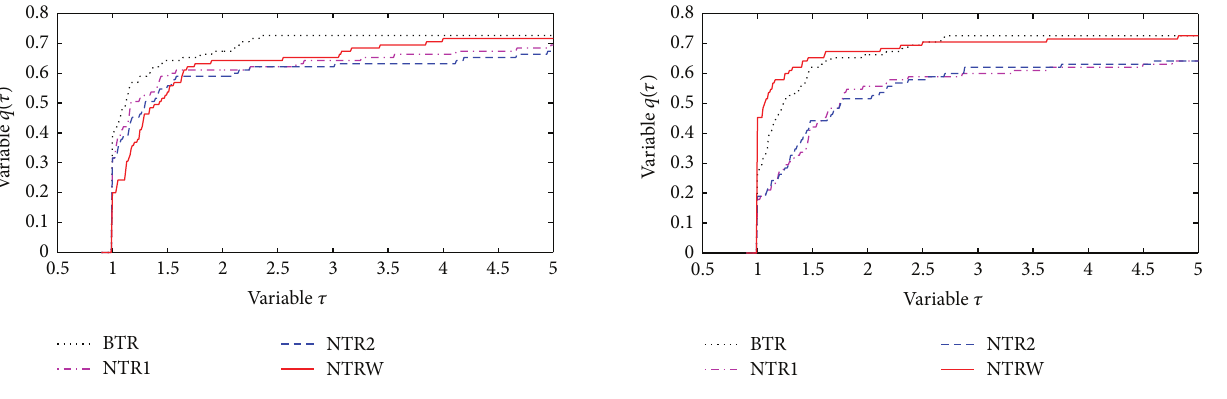
Figure 1: Performance profile comparing the number of iterations. Figure 2: Performance profile comparing the number of function